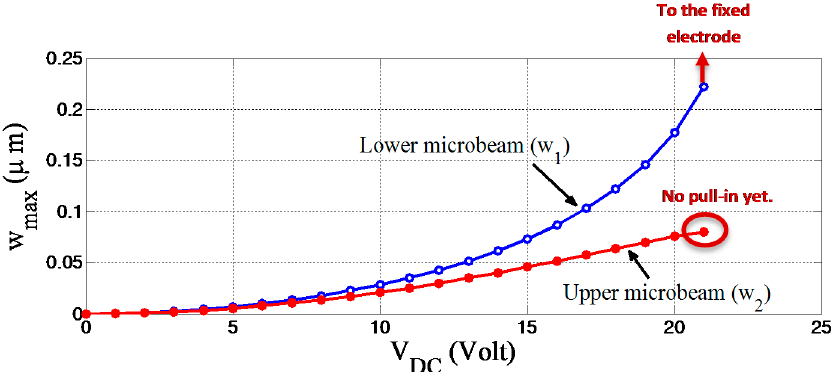
Figure 5. Variation of the maximum static deflection with the DC voltage for the lower and upper microbeams and for the case when d 1 < d 2 .